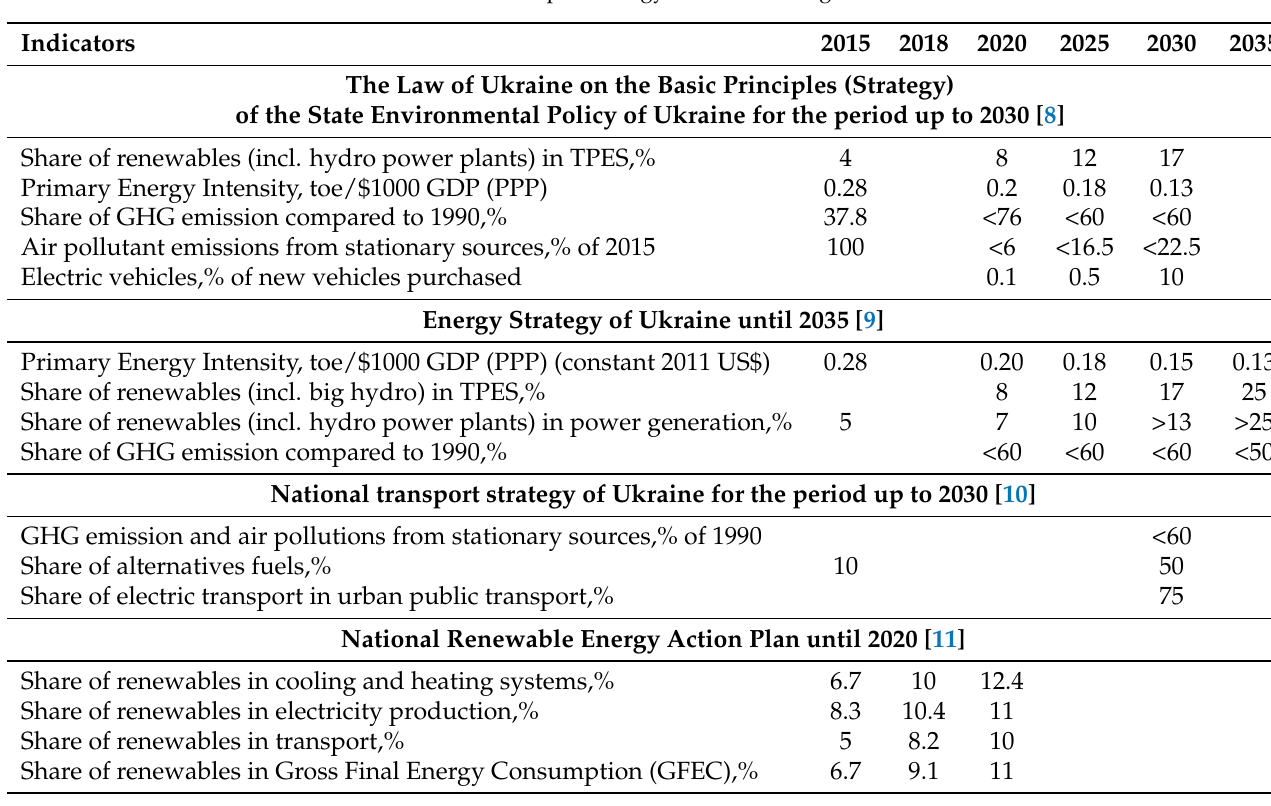
Table A2. Current adopted energy and climate targets in